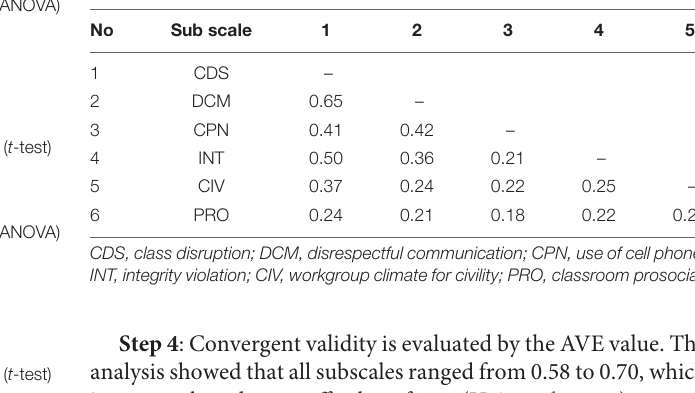
TABLE 3 | Heterotrait-Monotrait Ratio (HTMT) between sub-scale classroom incivility with civility and prosocial